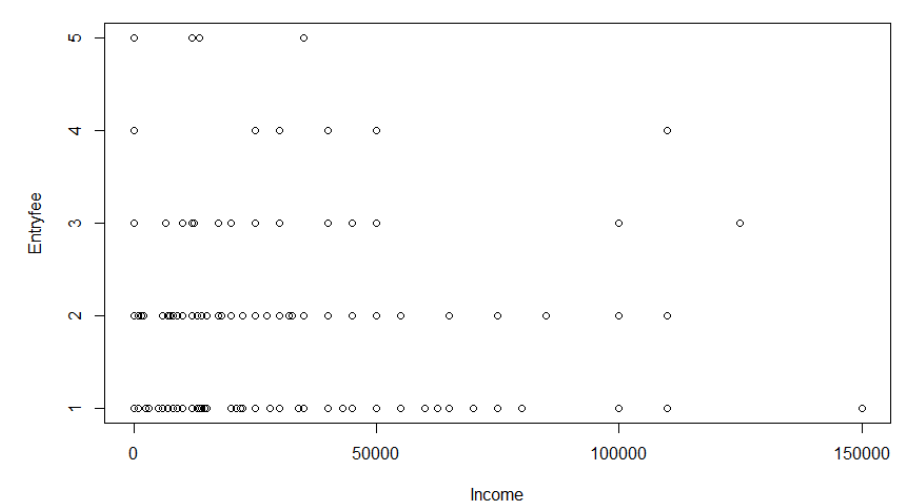
Fig. 4. Relationship between monthly income and entry